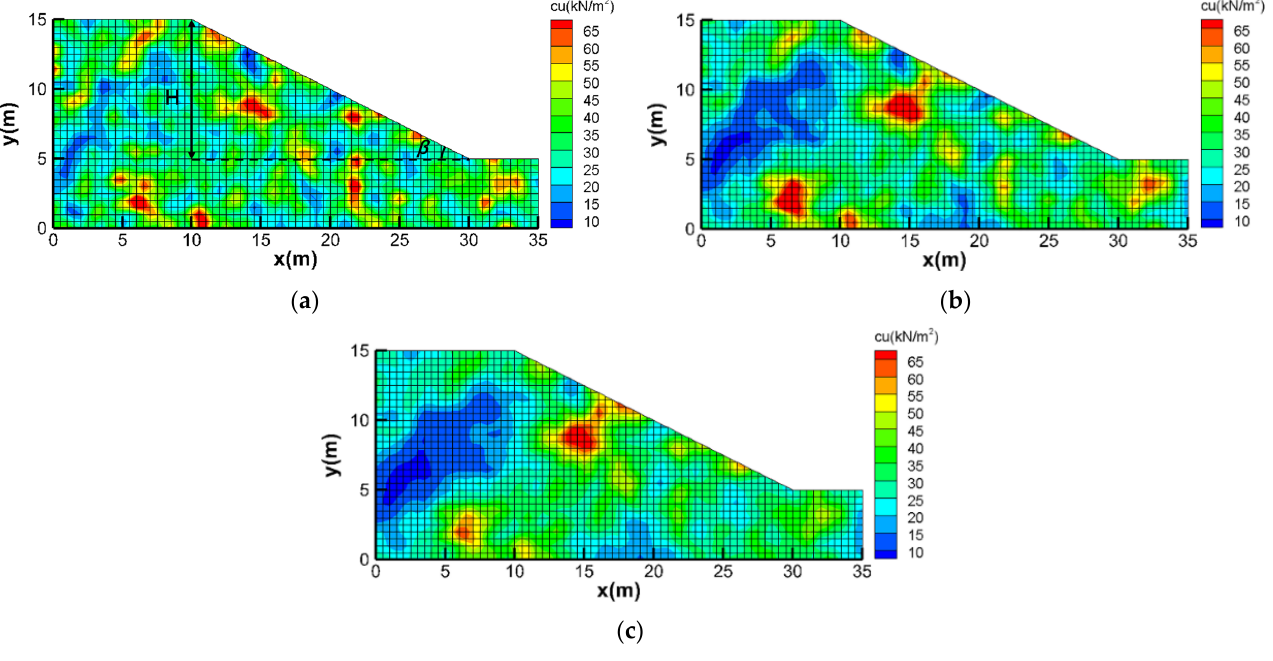
Figure 1. Numerically generated statistically isotropic undrained shear strength fields: ( a ) λ x = λ y = 0.5 m, ( b ) λ x = λ y = 2 m and ( c ) λ x = λ y = 5 m. ( b ) λ x = λ y = 2 m and ( c ) λ x = λ y = 5